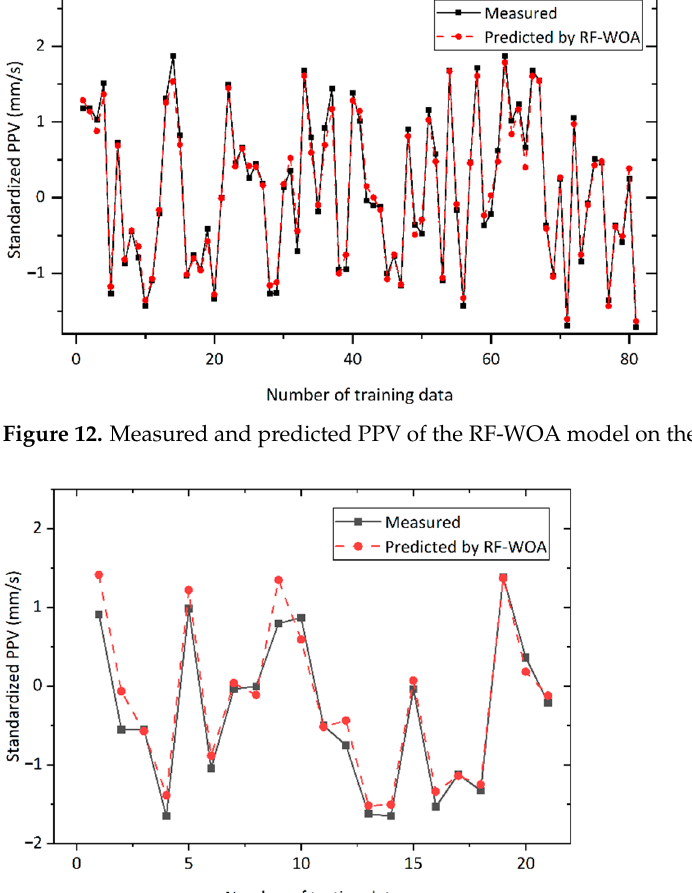
Figure 14. Significant correlation of the input variables with PPV. To obtain a clearer picture of how the PF affects the PPV, partial dependency plots (PDPs) are utilized to achieve this goal. The PDPs illustrate the intuitive relationship